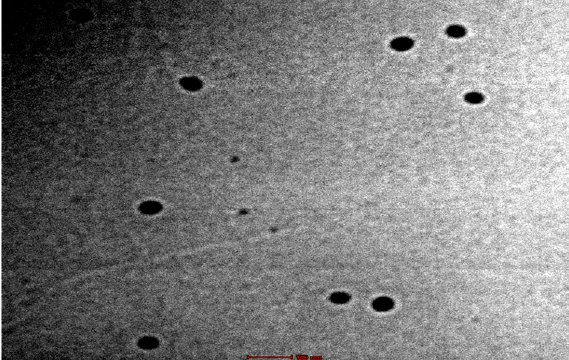
Figure 5. The TEM microphotograph of the microemulsion formulation F8 .